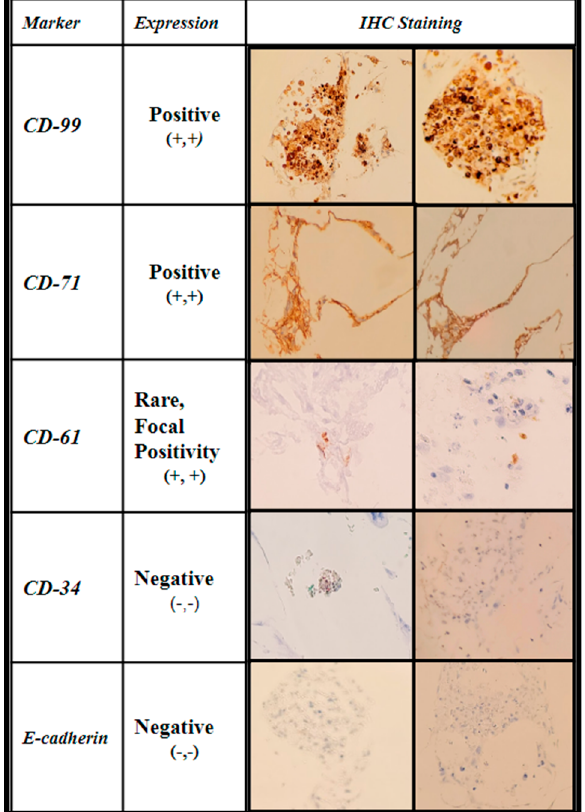
Figure 10. Immunohistochemical analysis of immature human bone marrow markers CD-99, CD-71, CD-61, CD-34, and E-cadherin of primary (hBM) seeded honeycomb infill PCL scaffold cultured for 21 days in rotating shaker culture.